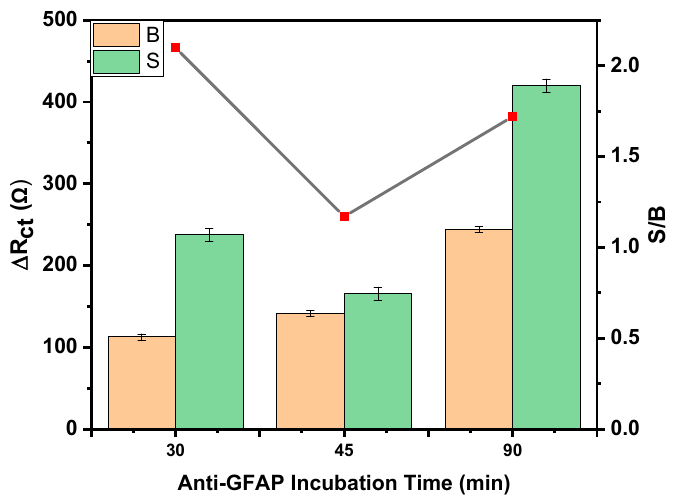
Figure 4. Effect of the anti-GFAP incubation time with the antibody solution on the R ct responses. Measured with the Anti-GFAP/L-cys/AuNPs/SPCE for 0 (B) and 100 (S) pg mL − 1 GFAP standard . In order to block the free and reactive glycydoxy ends to minimize non-specific adsorptions, the biosensor was rinsed into a solution of BSA. As a result, the optimum BSA concentration was found to be 1.5% (Figure 5a). Moreover, the highest value of ∆ Rct was obtained when BSA was incubated on the Anti-GFAP/L-cys/AuNps/SPCE surface for 60 min. Hence, the abovementioned values were chosen as the optimum values. Regarding the effect of the incubation time (Figure 6), the S/B values notably increased up to 60 min, and they decreased sharply over longer periods of time. The 60 min was adequate to allow for antibody and antigen interactions (Figure 6). The obtained results for these optimization studies are summarized in Table 1.